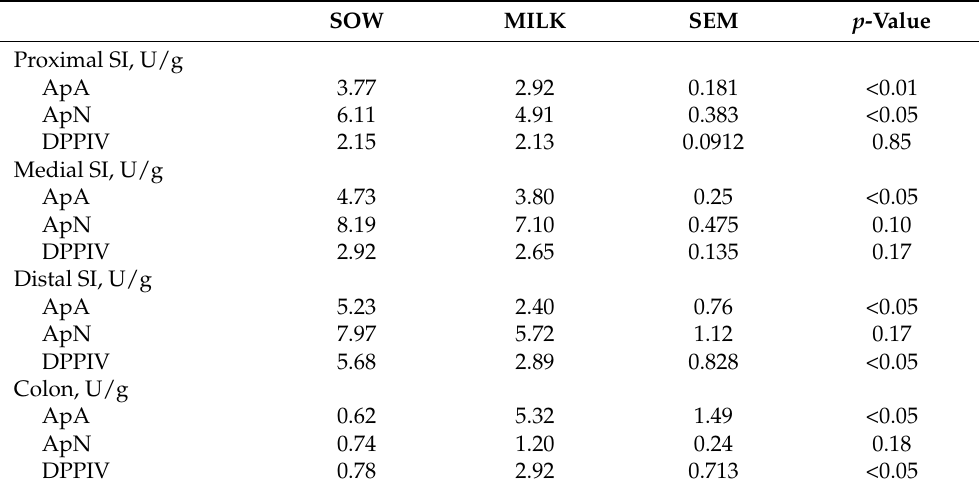
Table 6. Activity of aminopeptidases 1 in the proximal, medial, and distal part of the small intestine and in the colon of sow (SOW) and artificially (MILK) reared piglets. SOW MILK SEM p -Value Proximal SI, U/g ApA